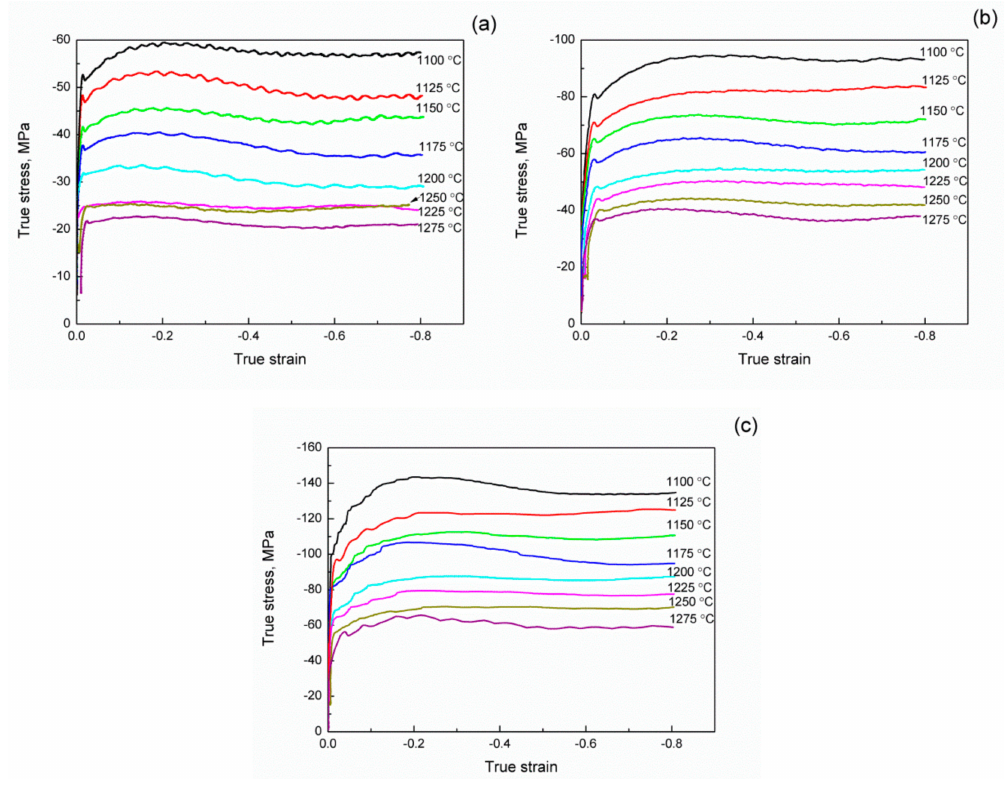
Figure 3. True stress curves at temperatures in the range of 1100 to 1275 ◦ C and strain rates of ( a ) 0.1 s − 1 , ( b ) 1 s − 1 and ( c ) 10 s − 1